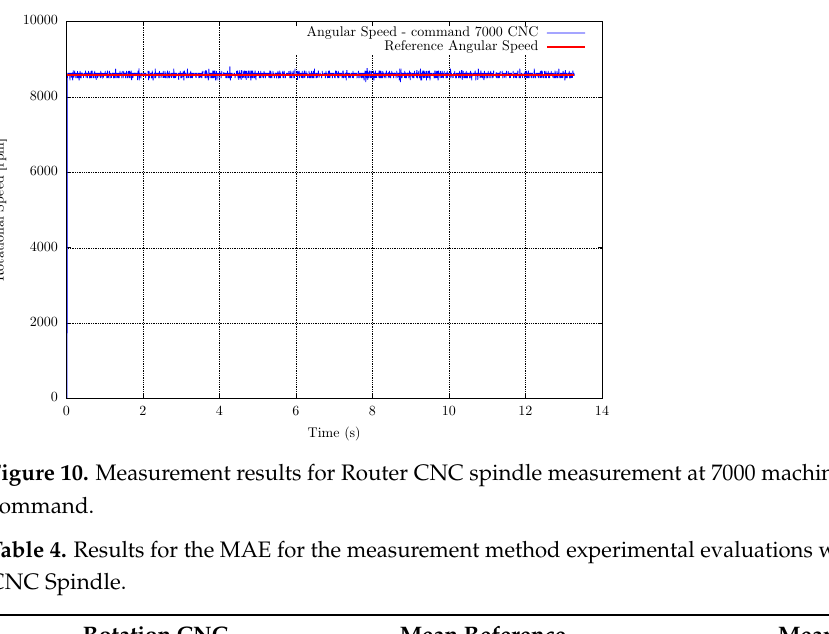
Figure 9. Measurement results for Router CNC spindle measurement at 5000 machining numerical command.